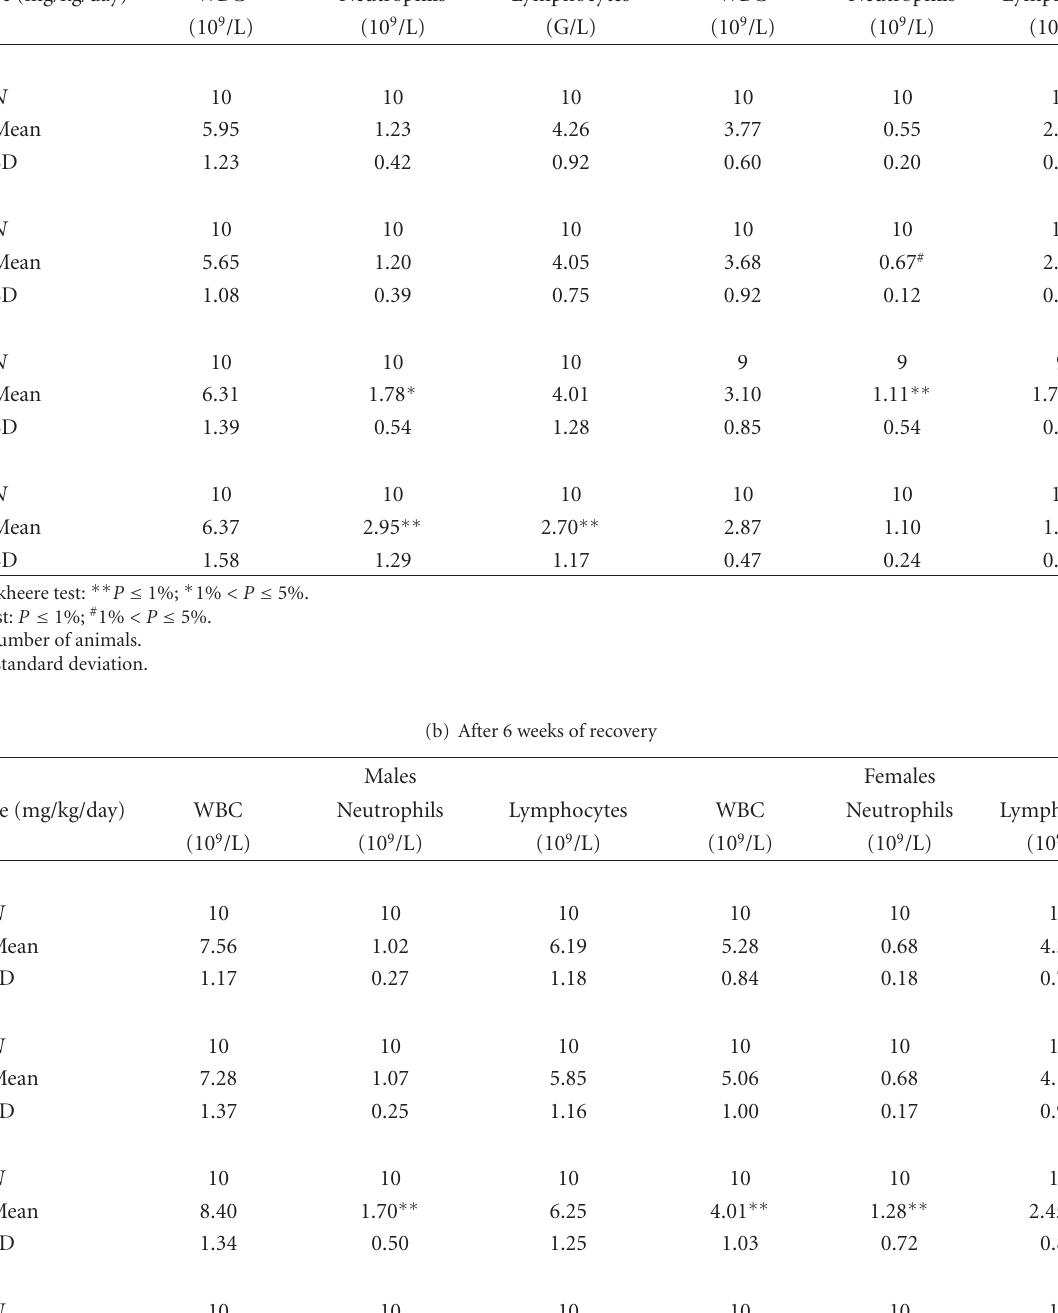
Table 1: E ff ects of RO4929097 on absolute numbers of white blood cells, neutrophils, and lymphocytes in male and female rats. (a) After 13 weeks of treatment